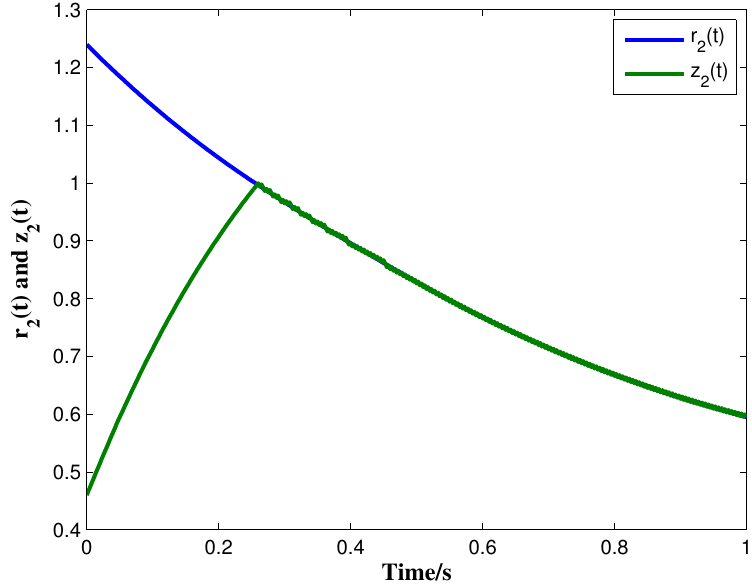
Figure 3. State trajectories of r 2 ( t ) and z 2 ( t ) with controller and